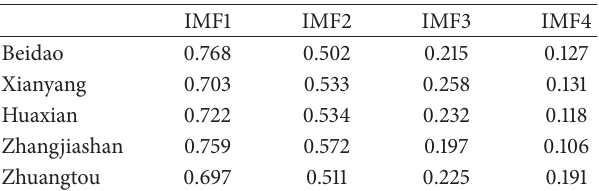
Table 1: Correlation coefficients of IMF components and original